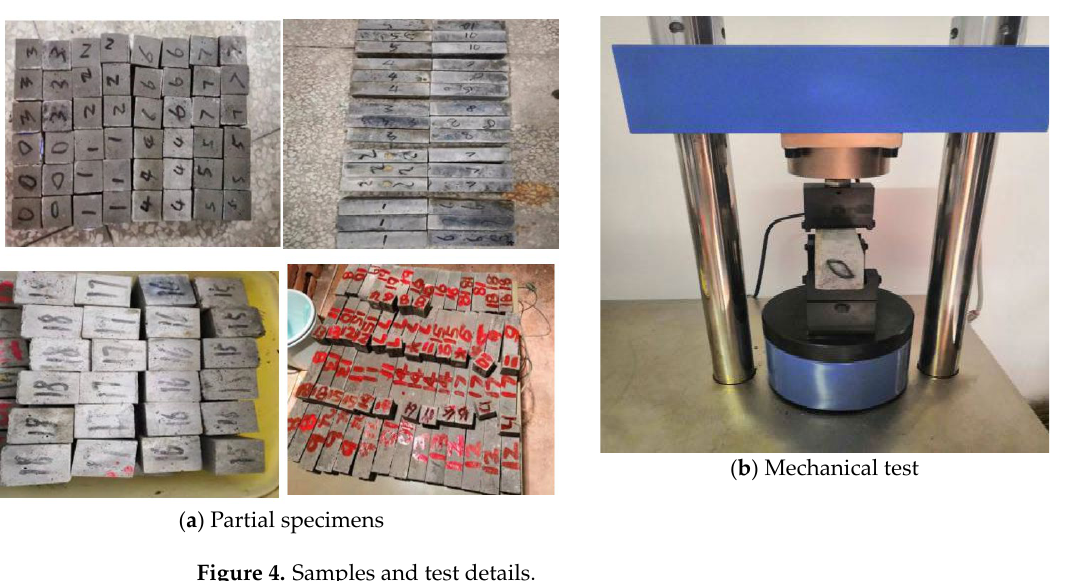
Figure 4. Samples and test details.